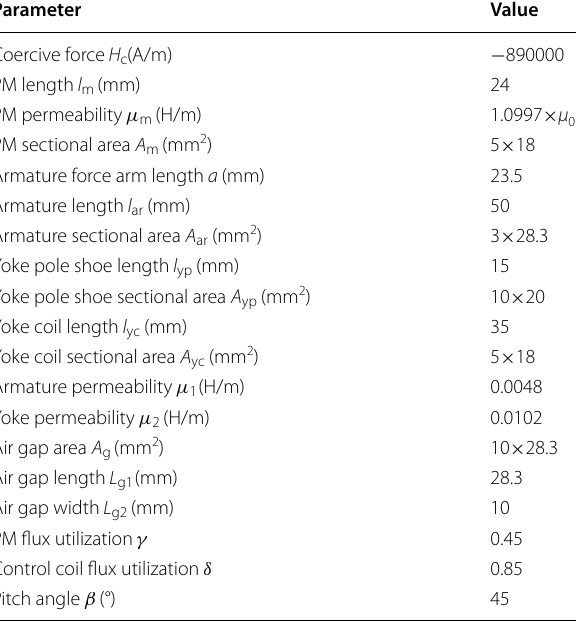
Table 3 Main design parameters for prototype of